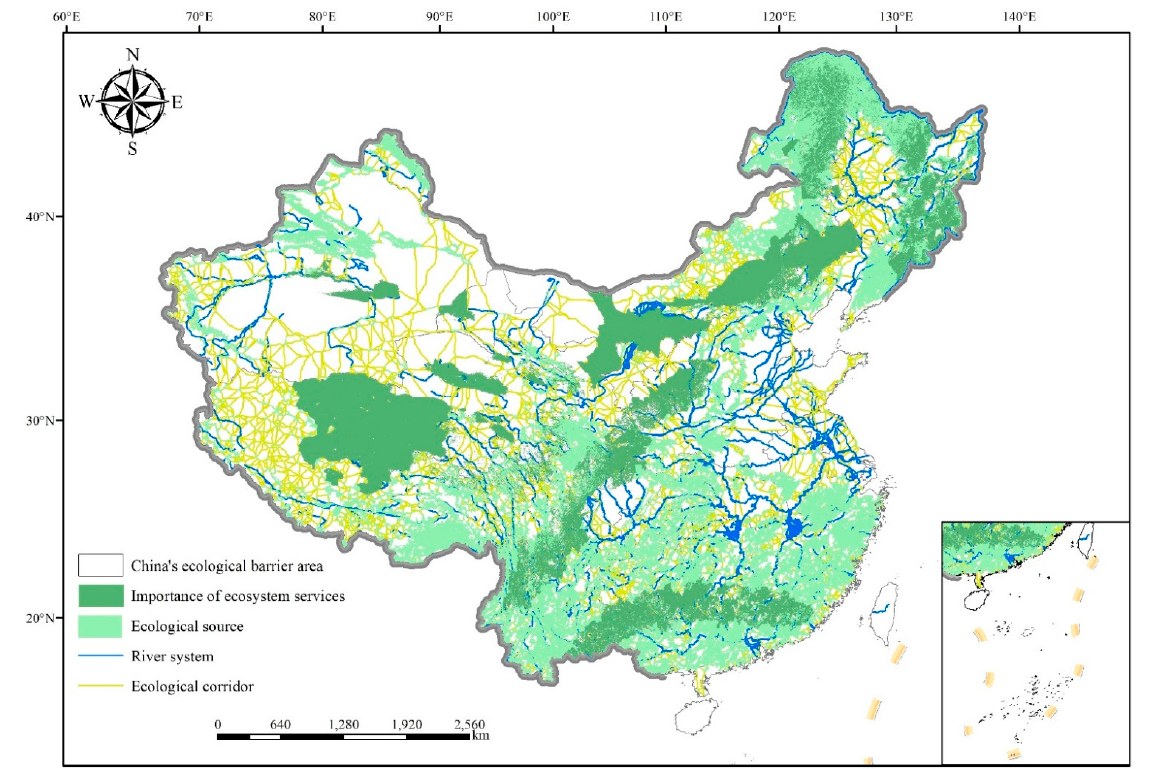
Figure 8. Optimization of China’s ecological space network structure.